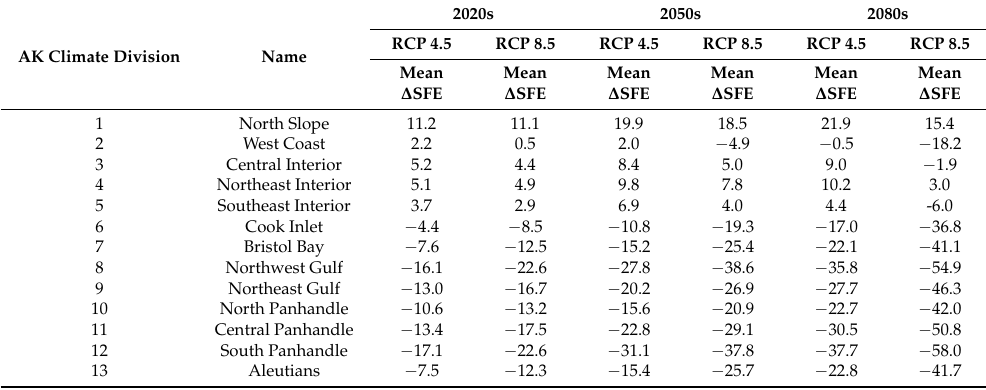
Table 5. Mean changes in SFE by Alaska Climate Division and climate scenario. All values are mean divisional change in SFE taken across the five Global Climate Model (GCM) composite. See Figure 1 for division